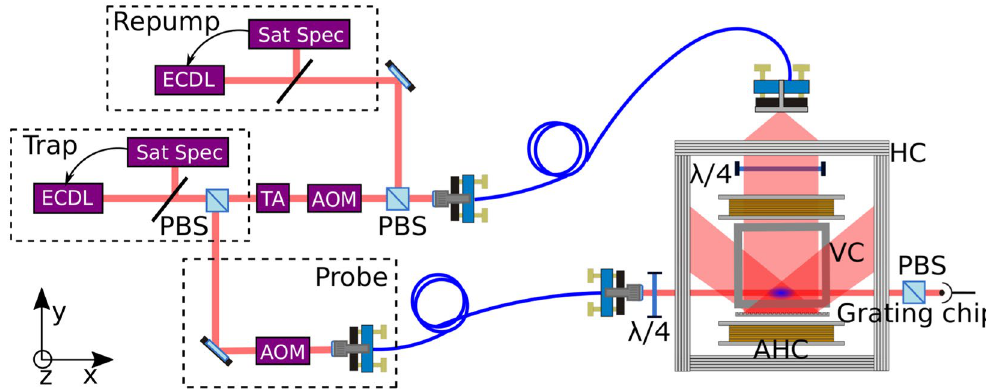
Figure 1. Schematic of the grating MOT experimental set-up. ECDL: External cavity diode laser, Sat Spec: Saturated absorption spectroscopy, TA: Tapered amplifier, AOM: Acousto-optical modulator, PBS: Polarising beam splitter, HC: Helmholtz coils, AHC: Anti-Helmholtz coils, VC: Vacuum